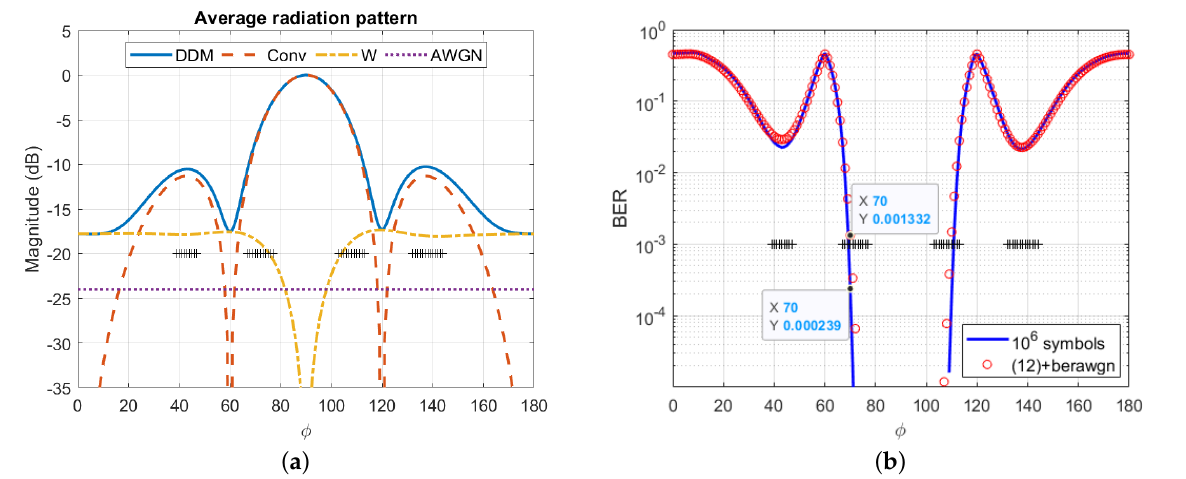
Figure 6. Array of four omnidirectional antennas along x-axis, spacing λ /2. Average radiation patterns ( a ) and BER ( b ) in XY plane for DDM. Zero mean artificial Non-Gaussian noise. QPSK modulation, φ 0 = 90 ◦ , SNR( φ 0 ) = 24 dB, PE DDM = 95%, P = 64. Only half plane is plotted due to symmetry. Black crosses mark those observation angles where (13) and (14) are satisfied and our approach may fail to predict accurately